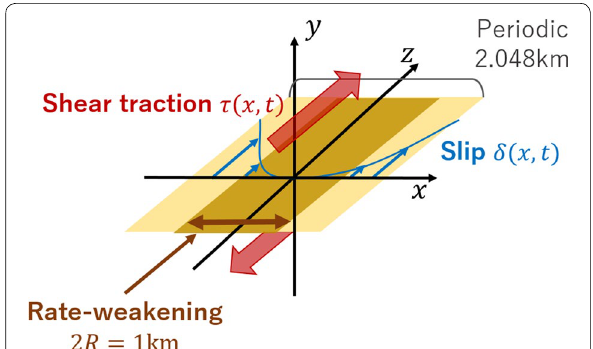
Fig. 1 Antiplane model studied in this study. A planar fault ( y = 0 ) is embedded in a Maxwell-viscoelastic material. A rate-weakening patch of a length of 2 R 1 km (a brown region) is surrounded by a = rate-strengthening region (a yellow region), and periodic boundaries are set approximately every 4 R as indicated by a gray bracket. Slip (blue arrows) and shear traction (red arrows) are in the z